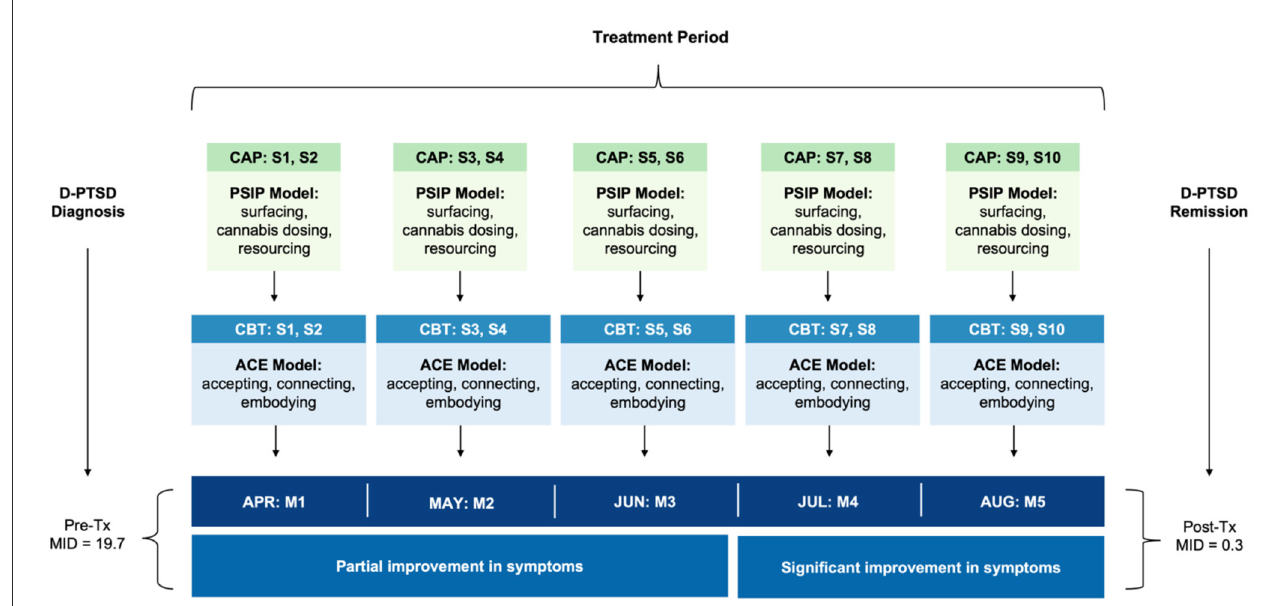
FIGURE1 Timeline of clinical events. The patient received 10 CAP sessions, scheduled twice monthly, two-to-three weeks apart, as a treatment for complex D-PTSD. An autonomic and relational approach to psychotherapy was leveraged, namely PSIP. Each CAP session was accompanied by CBT, using the ACE model for integration, to decode experiential phenomena. CBT sessions occurred within 1 week of CAP. ACE, accept, connect, and embody (psychotherapy); CAP, cannabis-assisted psychotherapy; CBT, cognitive behavioral therapy; D-PTSD, dissociative posttraumatic stress disorder; M, month; MID, multidimensional inventory of dissociation; PSIP, psychedelic somatic interactional psychotherapy; S, session; Tx, treatment.